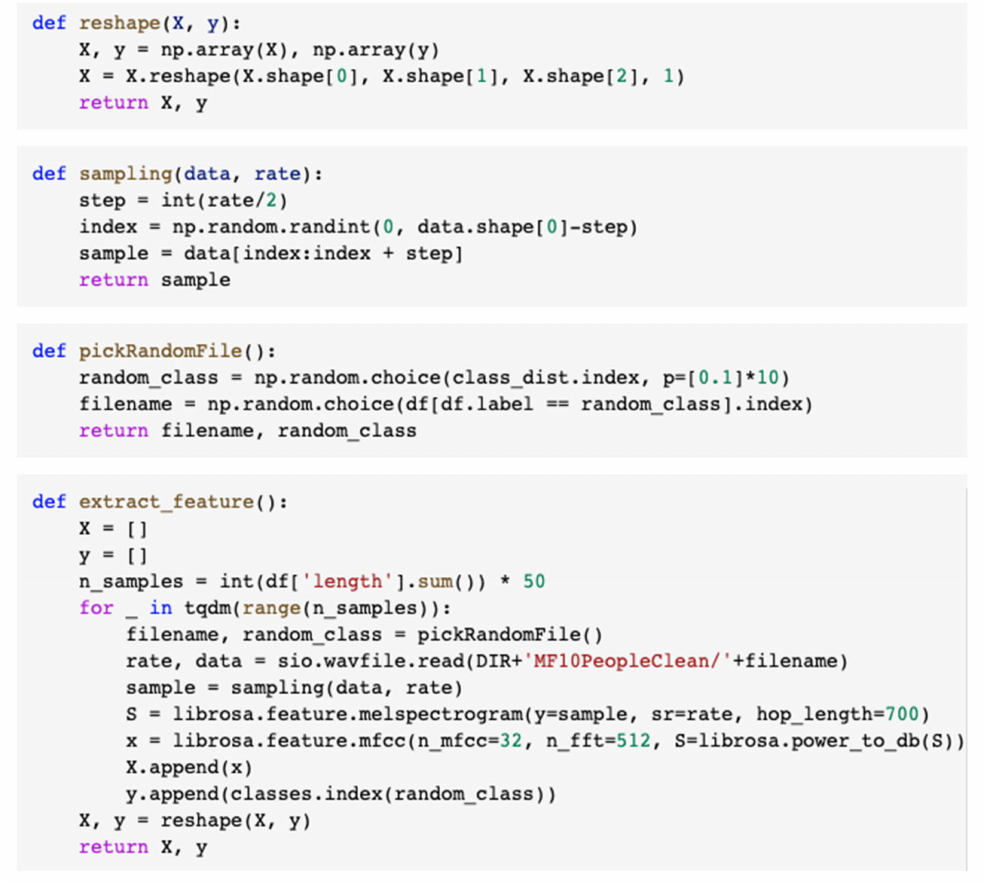
Figure A3. Feature Extraction Code.